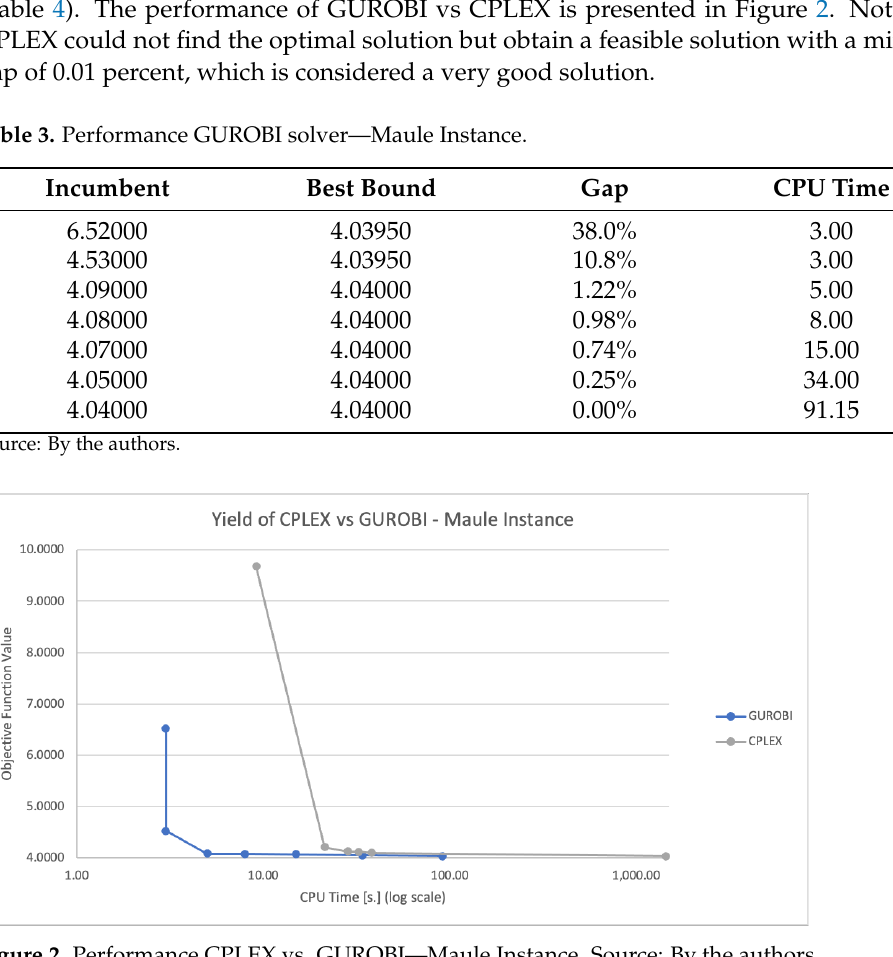
Figure 2. Performance CPLEX vs. GUROBI—Maule Instance. Source: By the authors. Table 4. Performance CPLEX solver—Maule